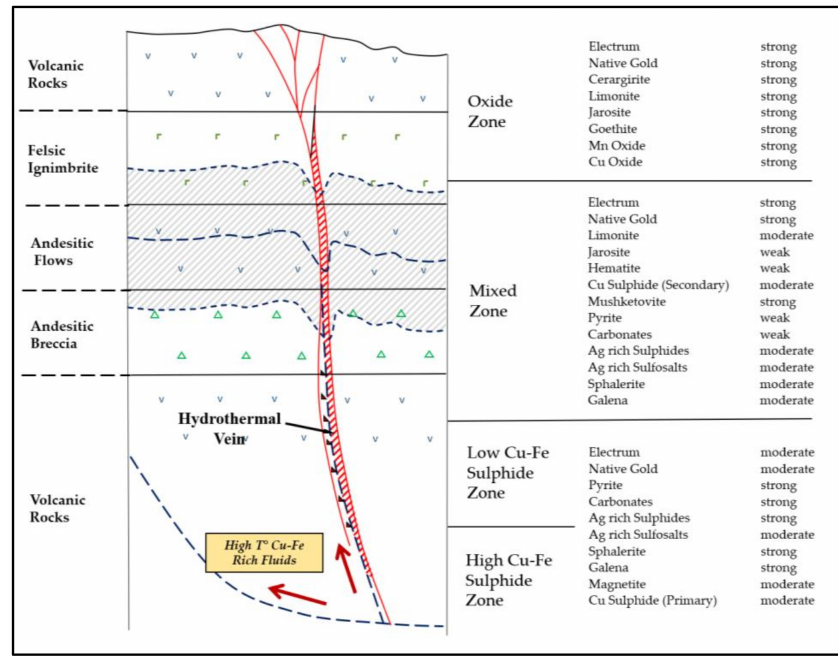
Figure 5. Schematic profile model of Alhu é veins. Spatial relationship of base metals and mineralogi- cal domains with the hydrothermal feeder, faults, and